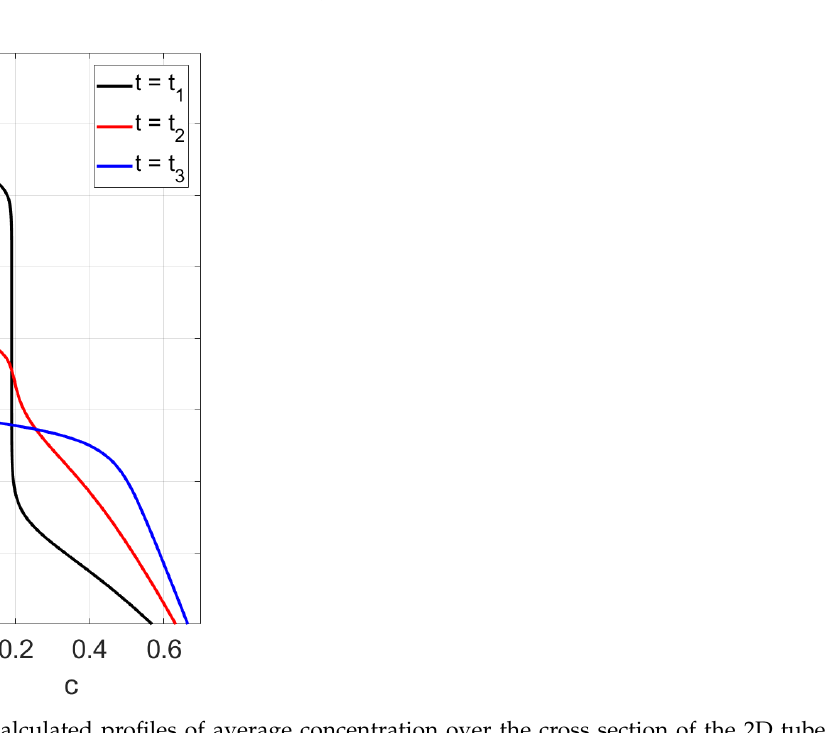
Figure 1. Calculated profiles of average concentration over the cross section of the 2D tube for different time instances in a vertical vessel in the case of mobility B rz